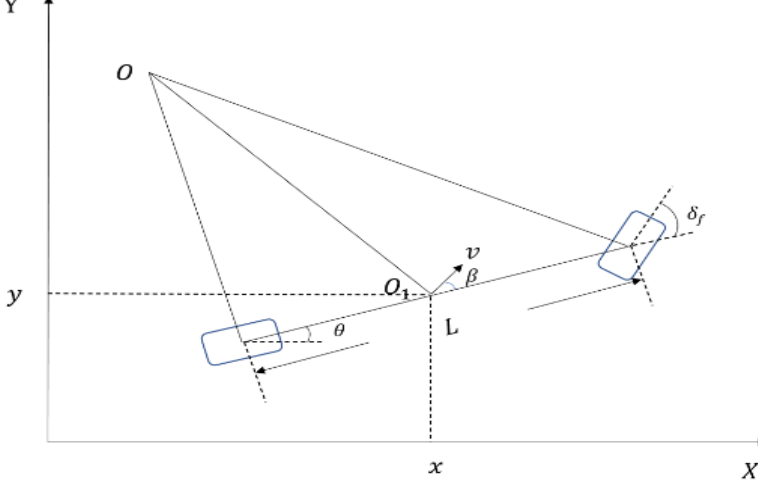
Figure 2. Kinematic bicycle model for autonomous vehicle.